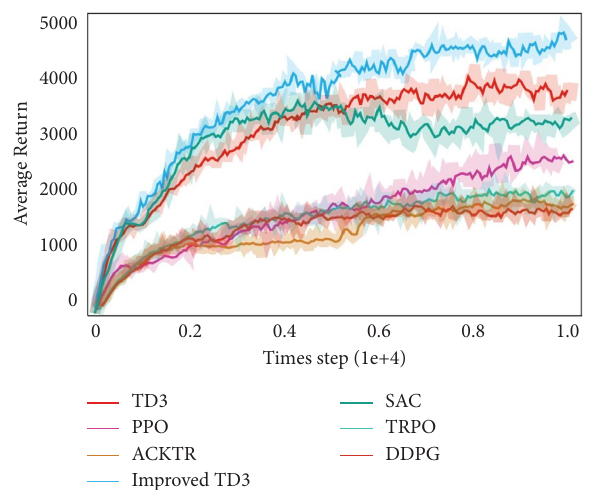
Figure 9: Comparison of average returns using seven diferent DRL